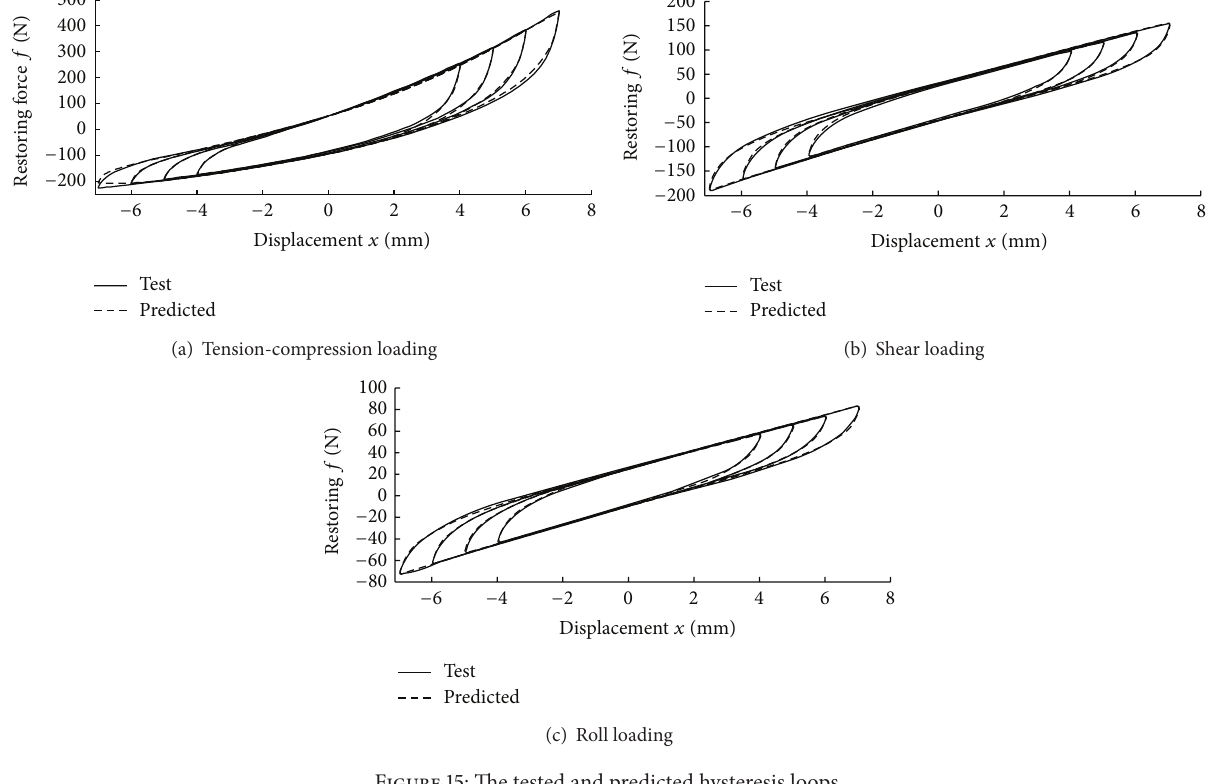
Figure 15: The tested and predicted hysteresis loops.